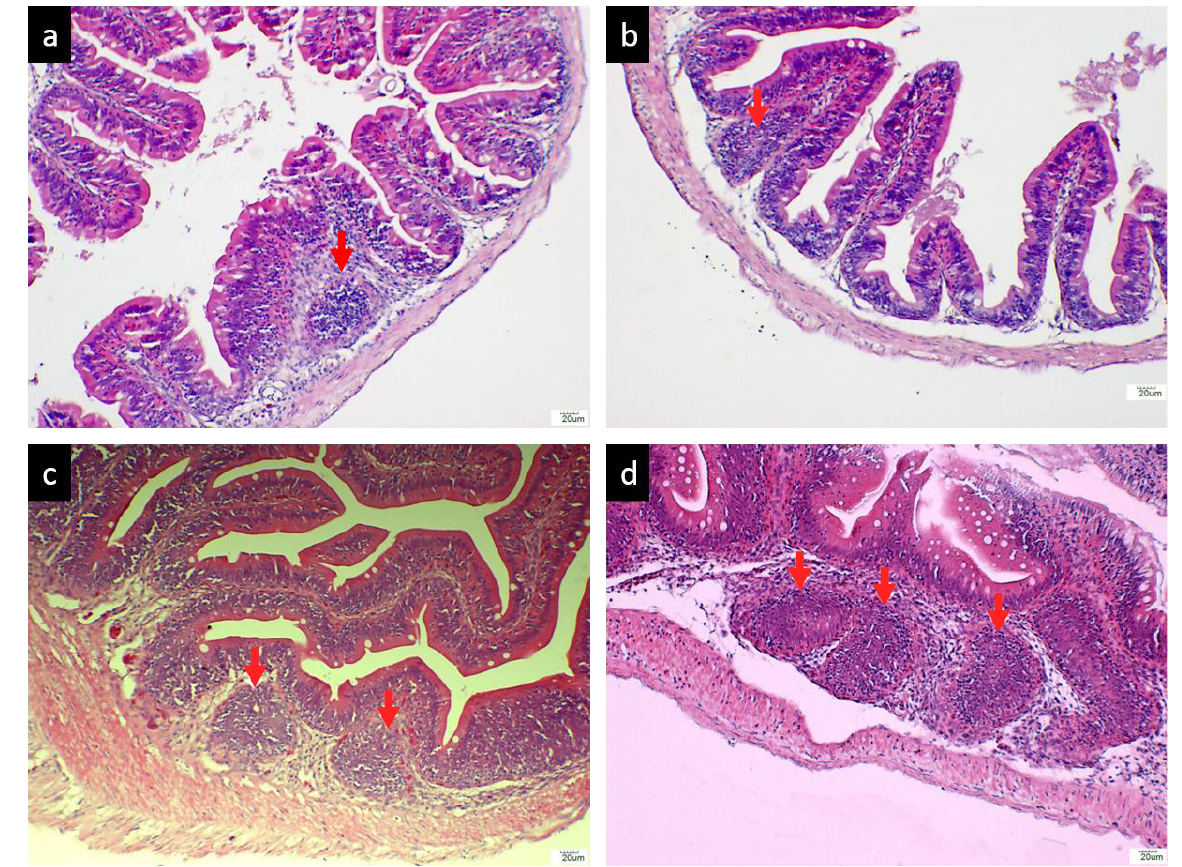
Figure 6. Histological sections of the hindgut of Red hybrid tilapia fed the formalin inactivated S. iniae vaccine (FKV) ( a ) Group 1A, tilapia fed with FKV vaccines for 3 days, developed the structure of GALT (red arrow) in the lamina propria, haematoxylin and eosin (H & E) × 200. ( b ) Group 1B, fed with FKV vaccines for 6 days, developed the structure of GALT (red arrow) in the lamina propria, H & E × 200. ( c ) Group 2A, fed with FKV vaccines for 9 days, developed two structures of GALTs (red arrows) in the lamina propria, H & E × 200. ( d ) Group 2B, fed with FKV vaccines for 9 days (2 times booster dose), developed more structures of GALTs (red arrows) in the lamina propria, H & E × 200.